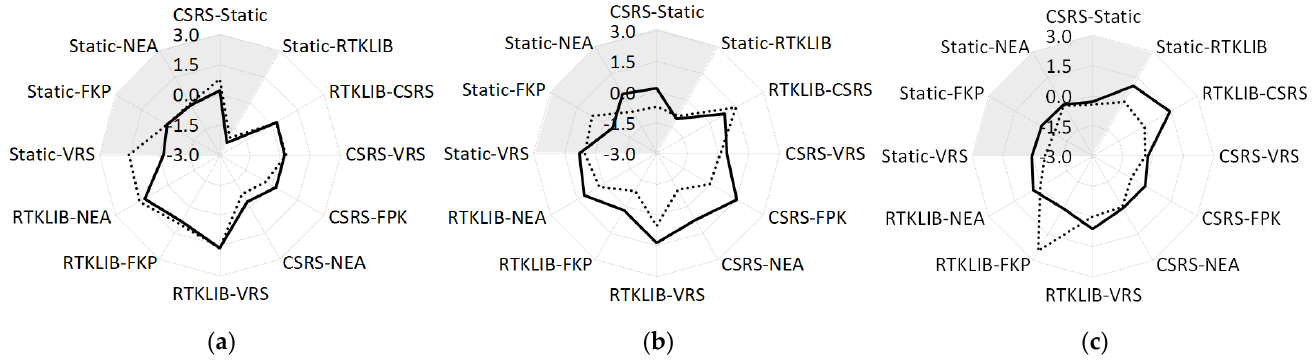
( c ) Figure 4. Standard deviation, σ (mm), of: ( a ) Δ N; ( b ) Δ E; ( c ) Δ h differences, pre and post outliers’ removal (dashed and continuous lines, respectively). The highest skewness characterizes the Δ N component of the Static vs. VRS and Static vs. CSRS differences (S ≈ 1.54 and 0.78, Figure 5, panel a, continuous line) and the Δ E component of the Static vs. VRS and Static vs. FKP differences (S ≈ 0.51 and 0.55). The extreme values removal generally reduces the asymmetry of the differences frequency